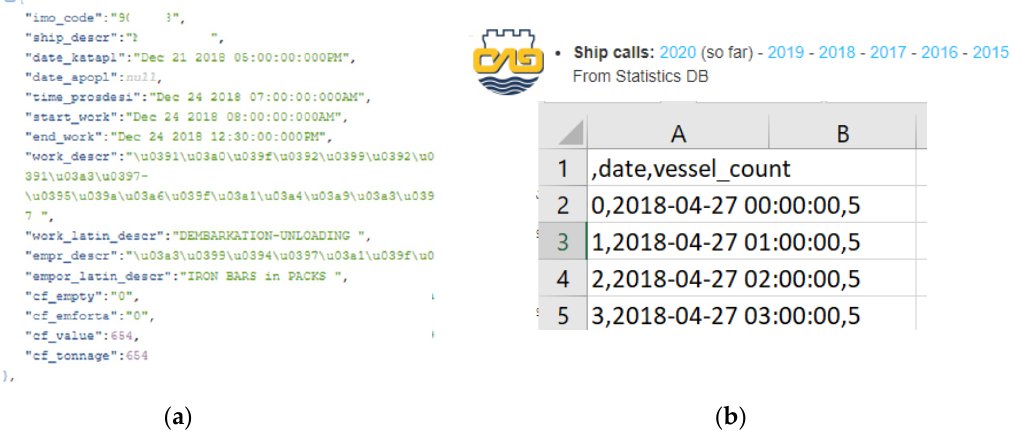
Figure 9. Vessel count per hour in the Port of Thessaloniki: ( a ) Raw data format; ( b ) Structure and management of historic CSV.